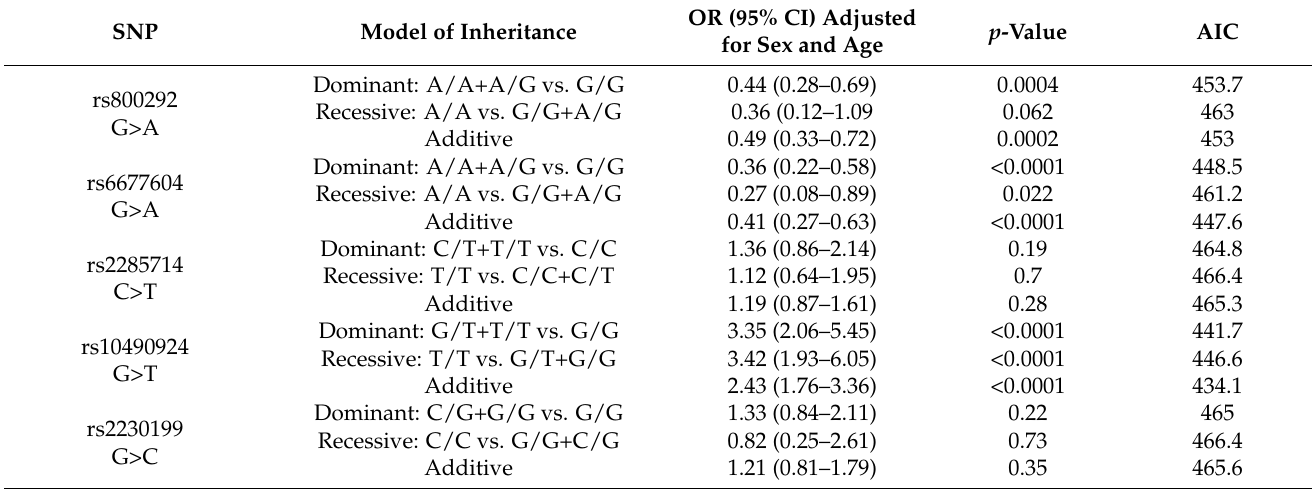
Table 4. Association of the studied polymorphisms with the risk of nAMD in Western Siberia